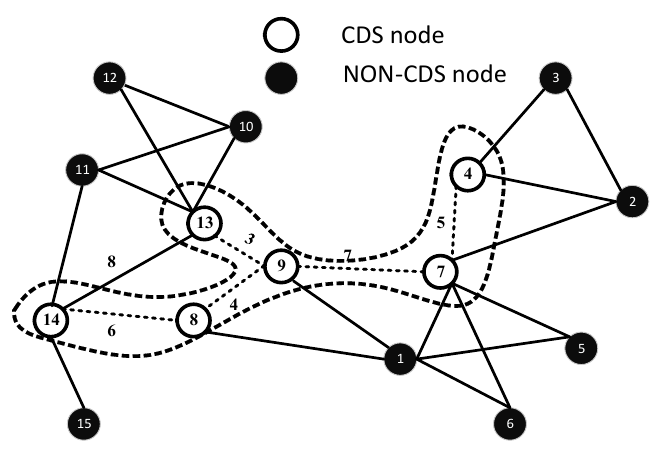
Figure 4. Trajectory of the AUV along the